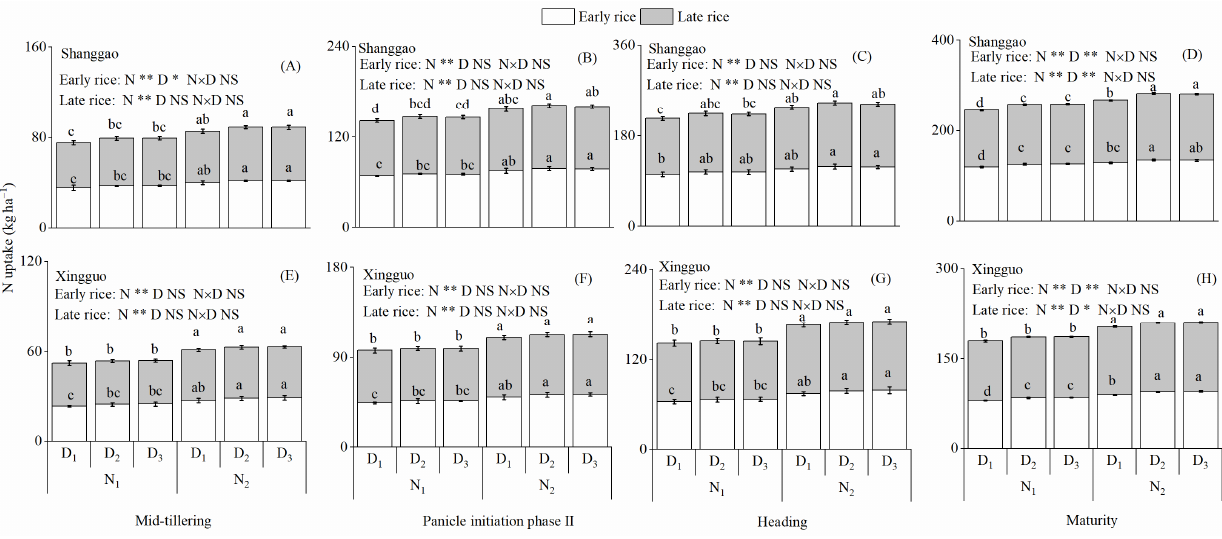
Figure 6. N absorption dynamics of double cropping rice ( A – H ) response to the N rate and plant density in two different ecological regions in 2018. N 1 and N 2 represent 120 and 150 kg ha -1 for early rice and N 1 and N 2 represent 120 and 165 kg ha -1 for late rice. D 1 , D 2 and D 3 represent 86, 143 and 200 plants per m 2 for early rice and D 1 , D 2 and D 3 represent 57, 114 and 172 plants per m 2 for late rice. Values followed by different lowercase letters are significantly different at the 0.05 level. NS, * and ** represent no significant difference and significant difference at the 5% and 1% levels.